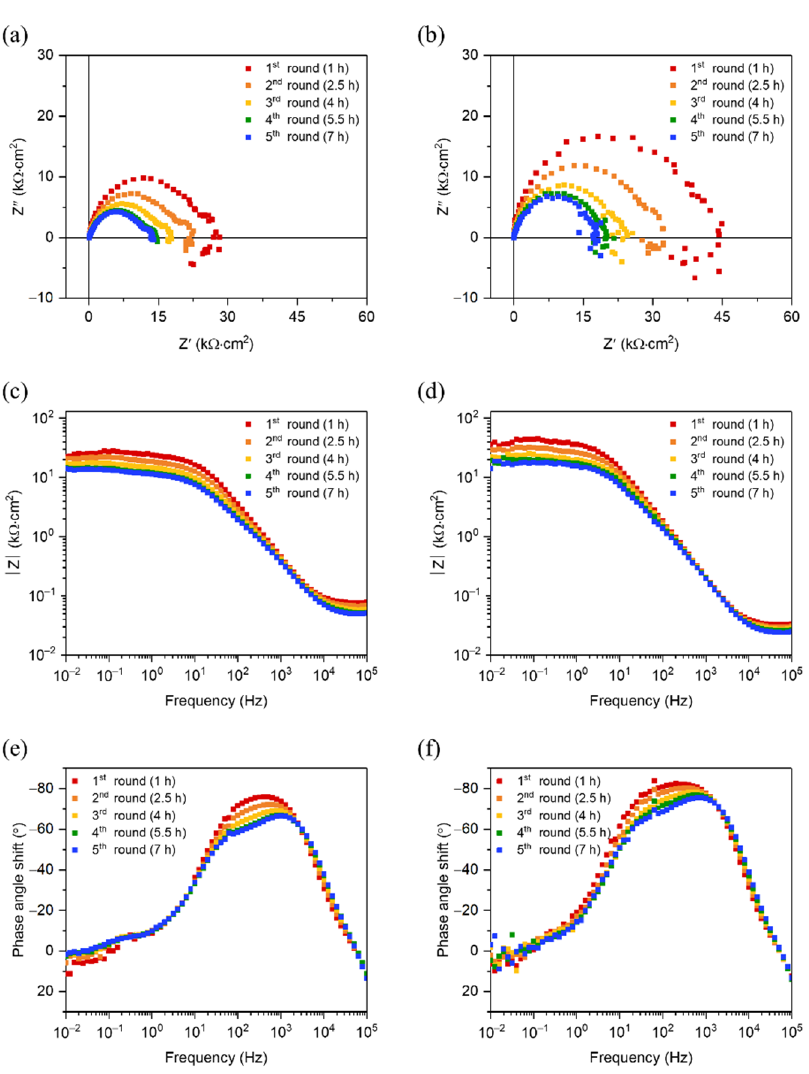
Figure 9. The results of continuous EIS measurement. ( a , b ) Nyquist plots, ( c , d ) Bode plots of absolute impedance, and ( e , f ) phase angle shifts of ZrO 2 and HZO films with the thickness is 200 cycles. The acquisition time of each round is corresponding to the corrosion time for sample.